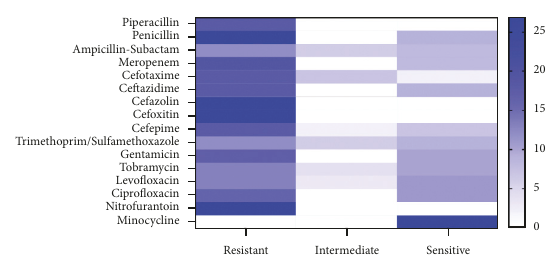
Figure 1: The heat map illustrating the different degrees of sus- ceptibility of the retrieved A. baumannii to different antimicrobial agents used in this study.